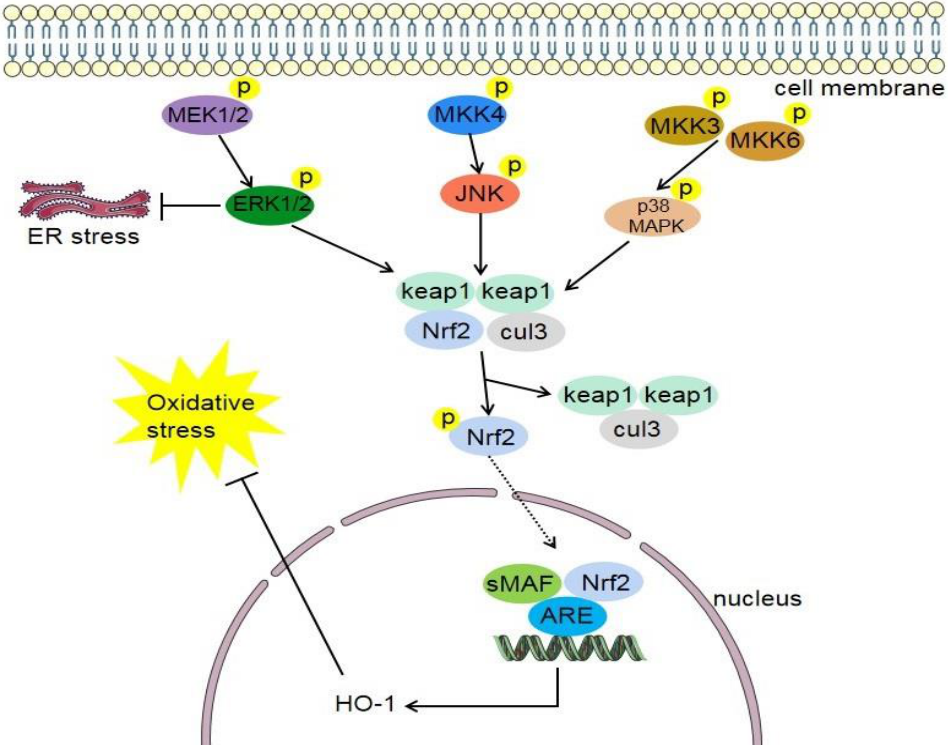
Figure 4. Mitogen-activated protein kinase (MAPK) pathway. It consists of three pathways which involve extracellular signal-regulated kinase 1 and 2 (ERK1/2), c-Jun N-terminal kinase (JNK), and p38 MAPK signaling pathways. Phosphorylated MEK1 and MEK2 promote the expression of ERK1 and ERK2, and then promote the dissociation of Nrf2 and Keap1. Phosphorylated MKK4 promotes the expression of JNK, and then promotes the dissociation of Nrf2 and Keap1. Phosphorylated MKK3 and MKK6 promote the expression of p38 MAPK, and then promote the dissociation of Nrf2 and Keap1. Nrf2 translocates into the nucleus, wherein it heterodimerizes with small Maf proteins (sMaf) and binds to an enhancer sequence termed ARE. This, in turn, promotes the expression of HO-1 and Oxygenase-1, and inhibits oxidative stress in feedback. MEK, mitogen-activated protein kinase; MKK4, MAPK kinase 4; MKK3, MAPK kinase 3; MKK6, MAPK kinase 6; ERK1/2, extracellular signal-regulated kinase 1 and 2; JNK, c-Jun N-terminal kinase; ER stress, endoplasmic reticulum stress; Keap1, cytoplasmic kelch-like epichlorohydrin-associated protein 1; Nrf2, nuclear factor erythroid 2-related factor 2; sMAF, small musculoaponeurotic fibrosarcoma; ARE, antioxidant response element; cul3, cullin-3; HO-1, heme oxygenase-1.